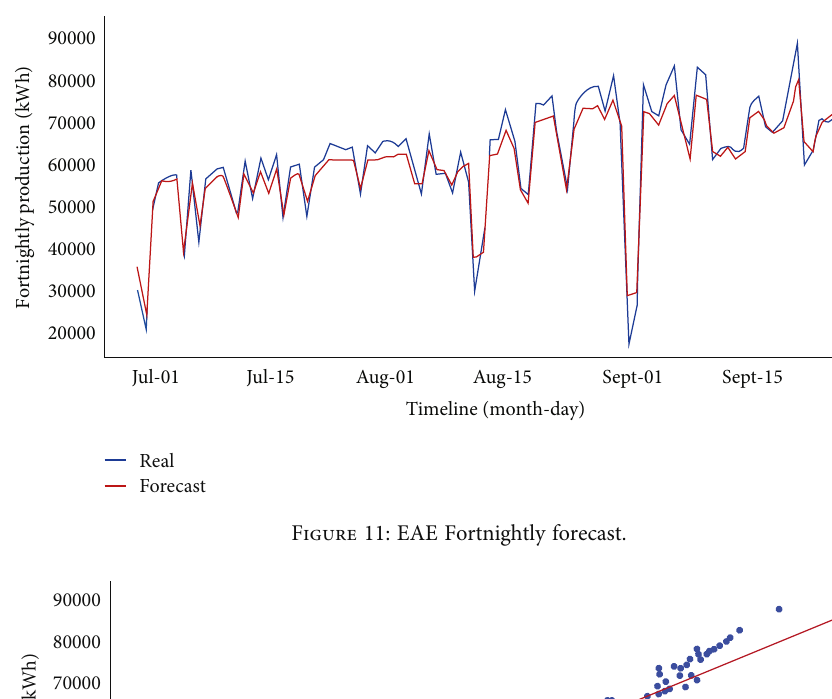
Figure 11: EAE Fortnightly forecast.